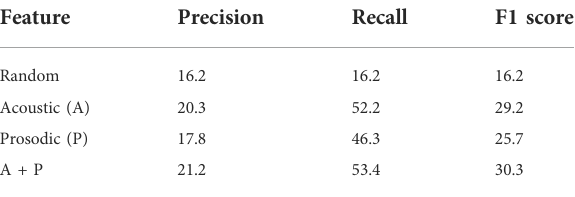
TABLE 3 Shared laughter prediction performance (%).